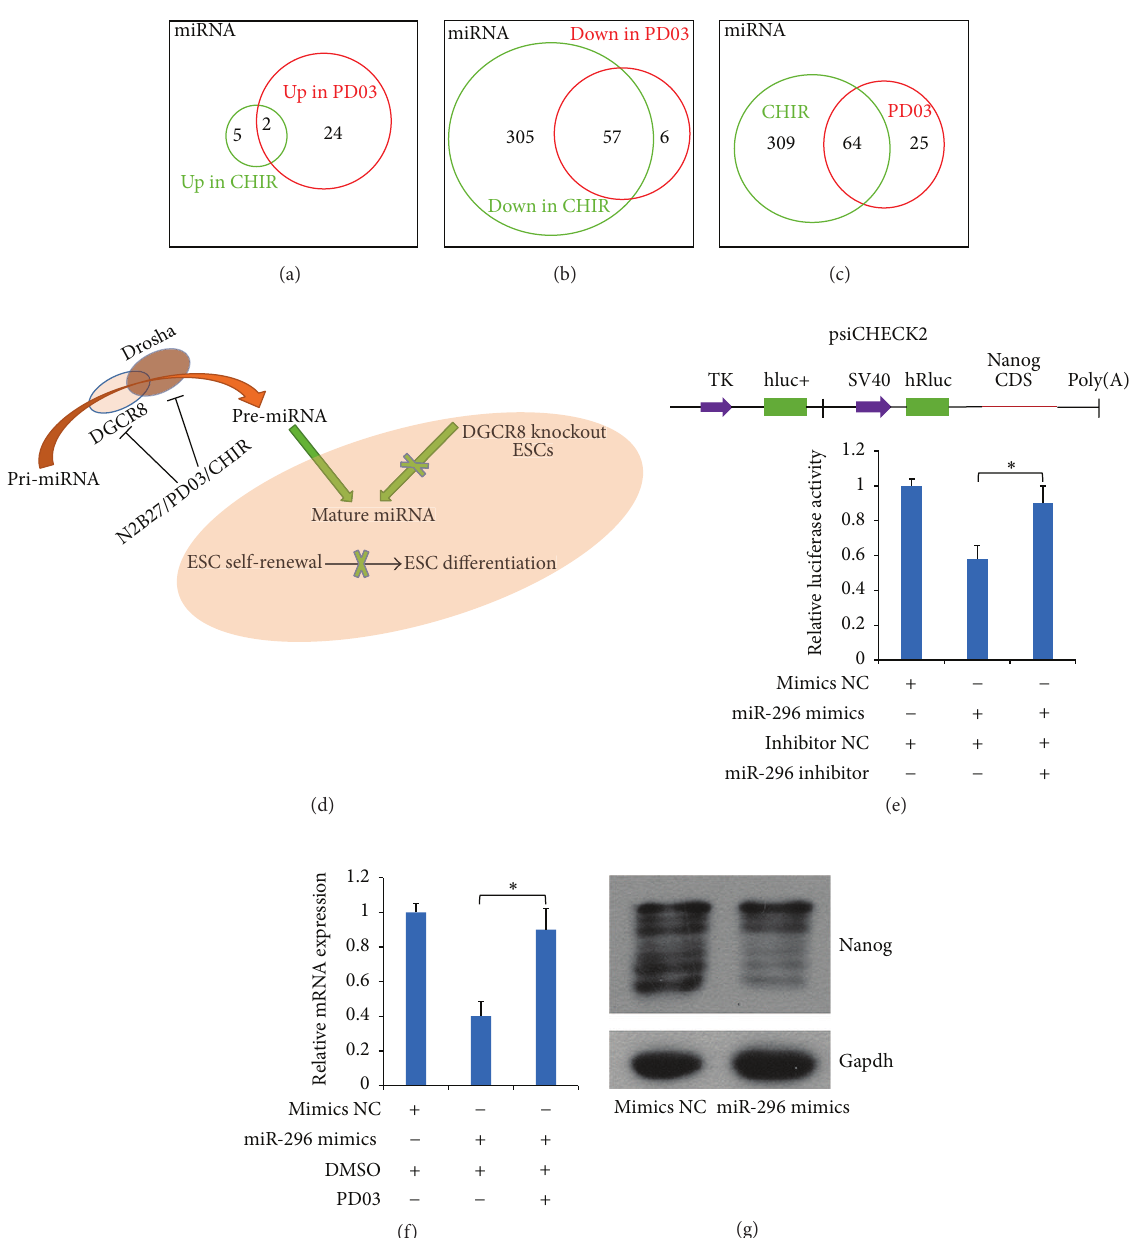
Figure 5: MEK/ERK signal-related miRNAs promote homogeneous ESC. (a–c) Venn diagram shows the differential expression of miRNA in PD- and CHIR-treated ESCs. Venn diagram showed the upregulated miRNAs (a) and the downregulated miRNAs (b) in PD- and CHIR- treated ESCs, respectively. The global differential miRNAs between CHIR- and PD-treated ESCs are shown in (c). (d) Schematic diagram of the miRNA biosynthesis and functions in maintaining the undifferentiated state of mESCs. PD and CHIR influence Dgcr8-Drosha complex activity. → means active and ⊥ means inactive. (e) miR-296 mimics regulated Nanog expression in a posttranscriptional regulation manner. Schematic representation of the 3 󸀠 -UTR reporter constructs in the upper panel. TK, hluc+, SV40, and hRluc represent HSV-TK promoter, firefly luciferase gene, SV40 early enhancer/promoter, and Renilla luciferase gene, respectively. In the lower panel, psiCHECK2-Nanog-CDS or psiCHECK2 control plasmid was cotransfected with mimics NC or miR-296 mimics/inhibitor into 293T cells. At 24h after incubation,